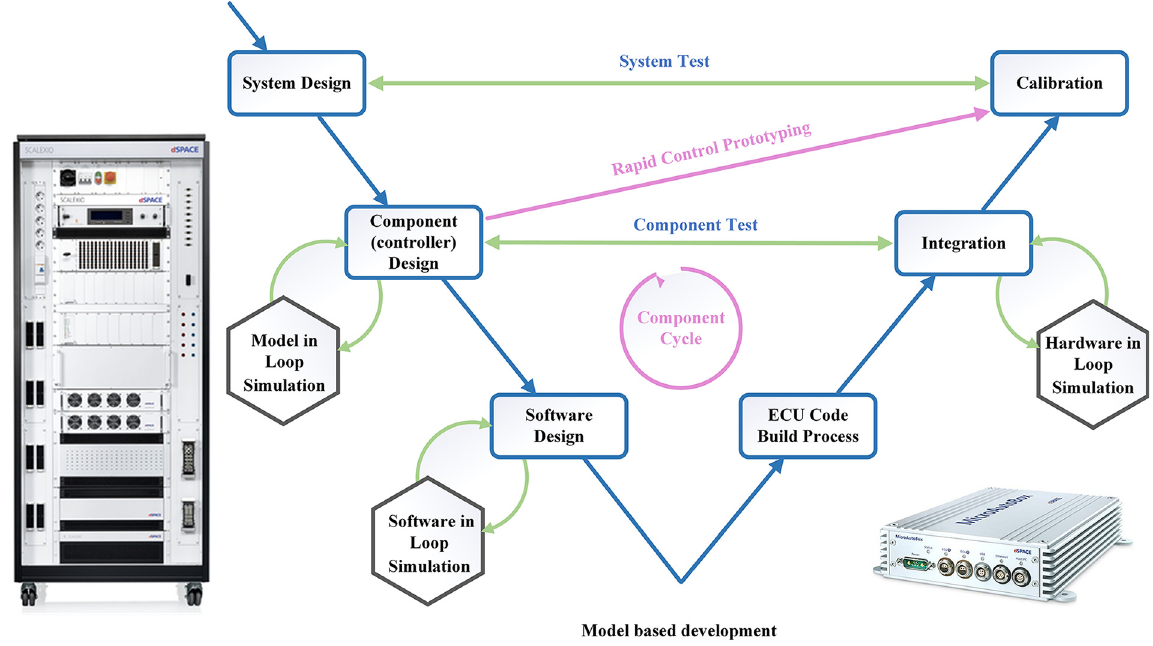
Figure 1 V-model for model-based